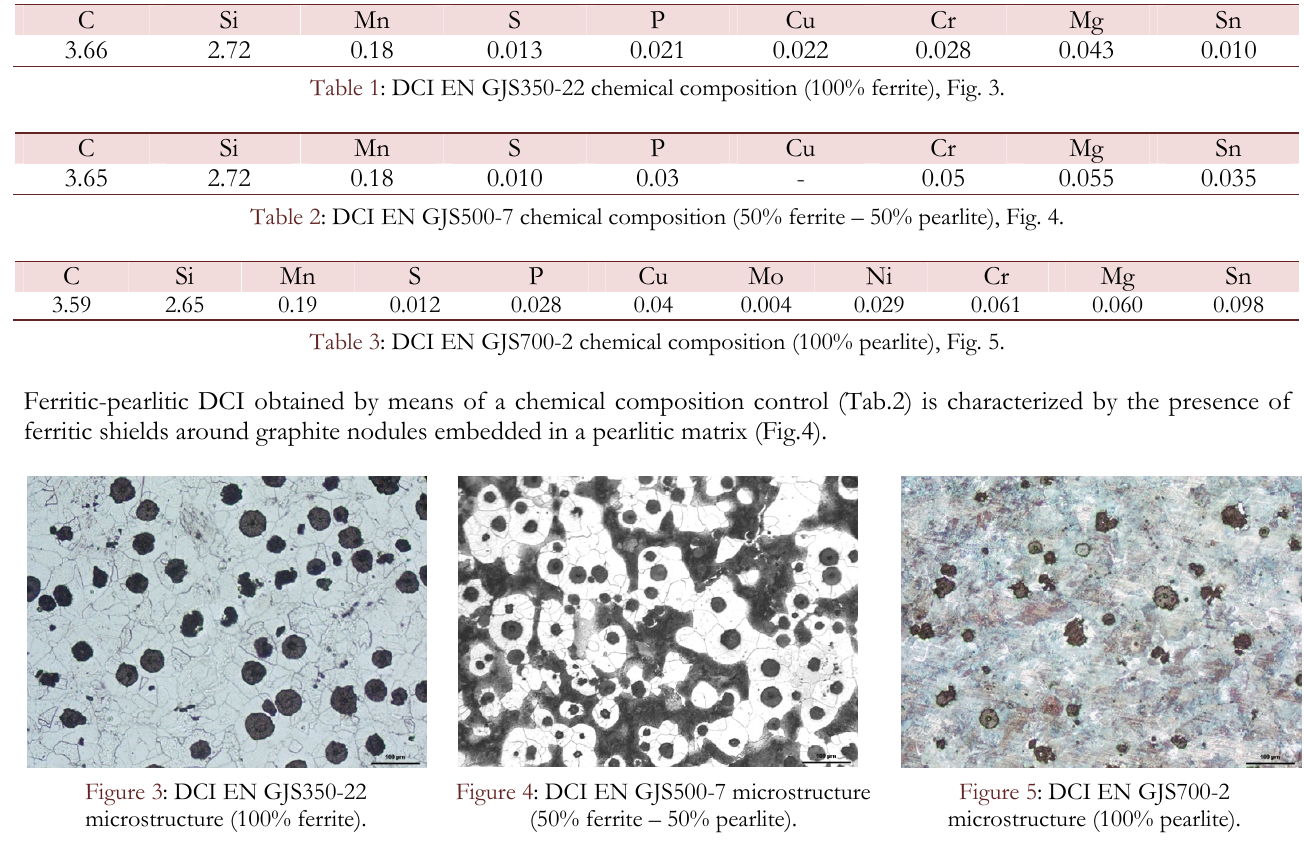
Figure 3: DCI EN GJS350-22 microstructure (100% ferrite).